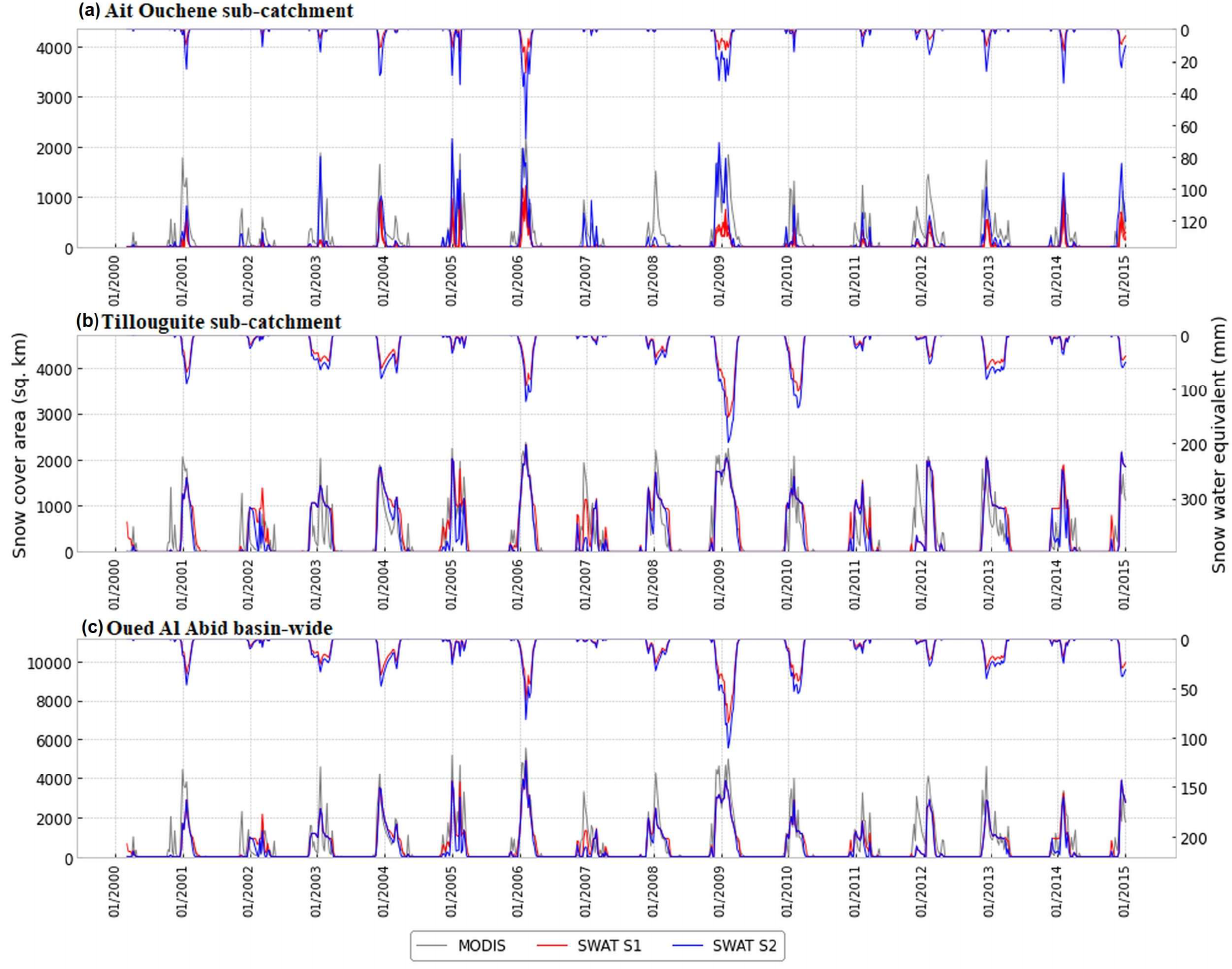
Figure 3. Weekly evolution of MODIS-SCA, SWAT-SCA, and SWE in the sub-catchments of ( a ) Ait Ouchene, ( b ) Tillouguite, and ( c ) Oued El Abid basin-wide.